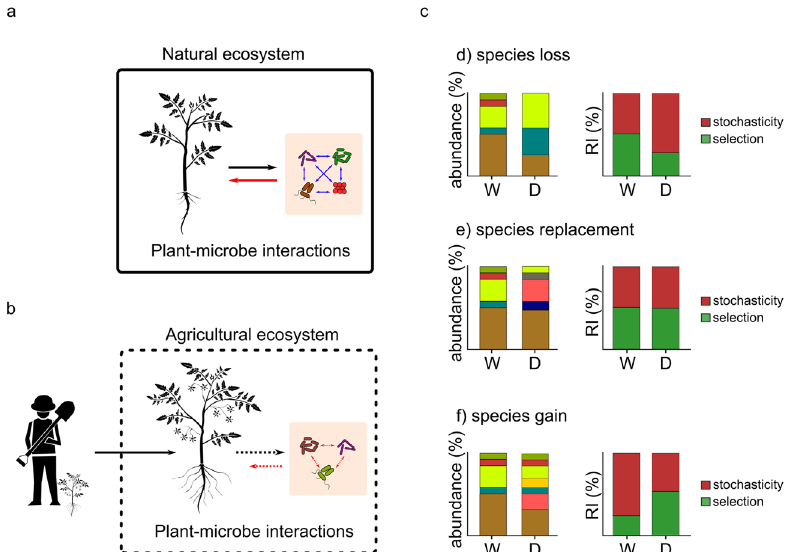
Fig. 1 Differences in plant microbiomes between wild and domesticated plants are governed by host-to-microbe and microbe-to-microbe effects dictated by plant domestication. a Wild plants are under natural selection to control their microbiota for positive microbe-to-host effects. Black arrow indicates host-to-microbe effects (the leash) and red arrow microbe-to-host effects. Microbe-to-microbe effects are indicated by blue arrows. The black line surrounding host and microbiome represents the natural environment. b Domesticated plants are under arti fi cial and indirect selection. The domesticator strongly in fl uences the plant genotype through arti fi cial selection ( fi rst leash, black arrow) and indirect selection exerted by the agricultural ecosystem (black dotted line surrounding host and microbiome), so that the positive microbe-to-host effects arising from host control of the microbiome (second leash, black dotted arrow) are reduced (red dotted arrow). Under these circumstances, domesticated plant microbiomes are ecosystems on a double leash from domesticator to host and host to microbe. Additionally, the agricultural ecosystem can affect microbe-to-microbe and host-to-microbe interactions, with consequences for microbe-to-host effects. cd-f The double-leash hypothesis could predict species loss ( cd ), replacement ( ce ), and gain ( cf ) caused by different host-to-microbe effects induced by domesticated plant phenotypic traits. Different colours in the relative abundance charts indicate different microbial members. W wild-type plants. D domesticated plants. RI Relative importance of the ecological processes driving community assembly. Plant drawings were downloaded from iStock under standard license